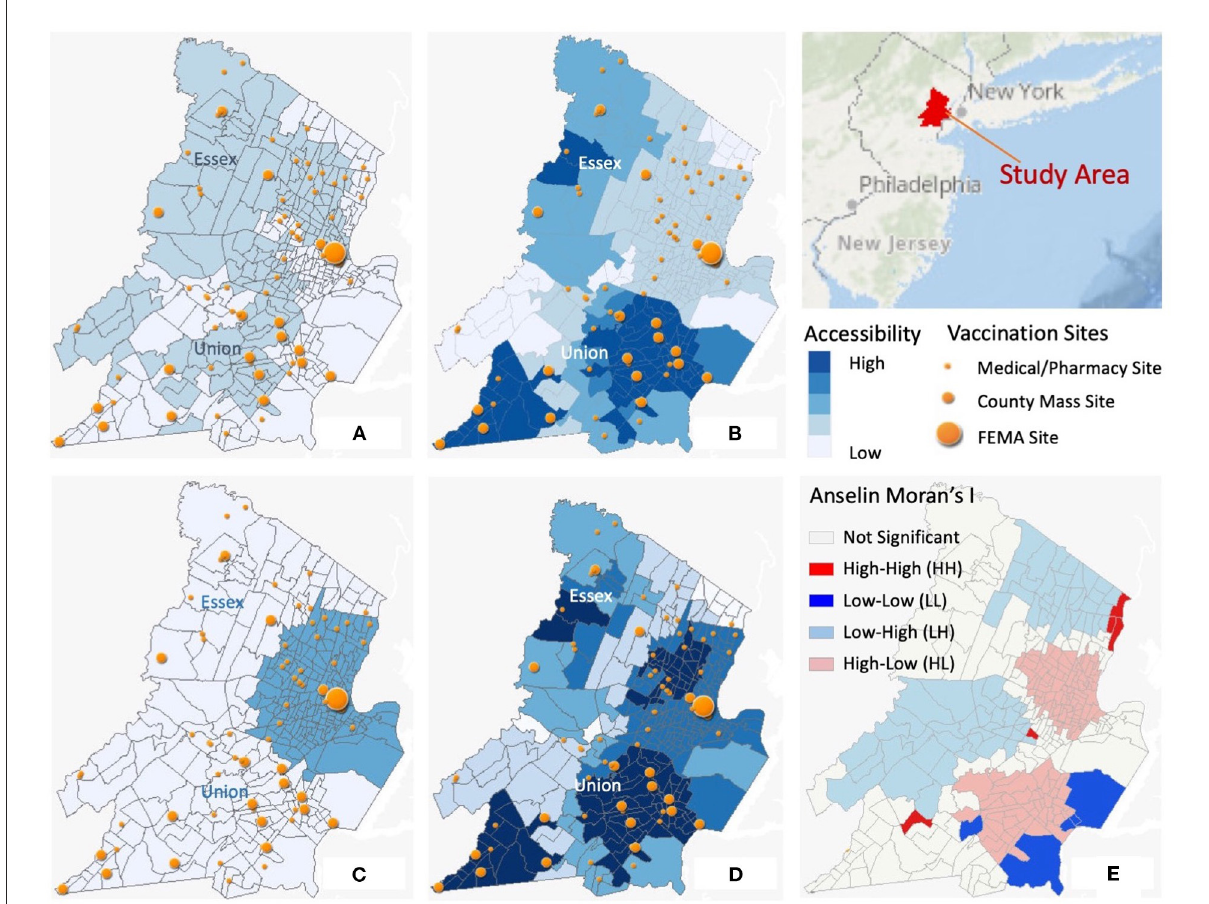
FIGURE1 Spatial distributions of accessibility scores. (A) Accessibility with medical/pharmacy sites only; (B) Accessibility with county mass sites only; (C) Accessibility with FEMA sites only; (D) Accessibility with all sites combine; (E) Cluster analysis with Anselin Moran’s